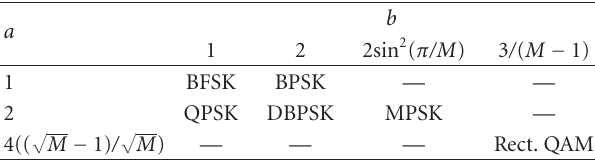
Figure 10: BEP/SEP for noncoherent detection, dual-branch diversity. Table 2: Values of a and b for some coherent